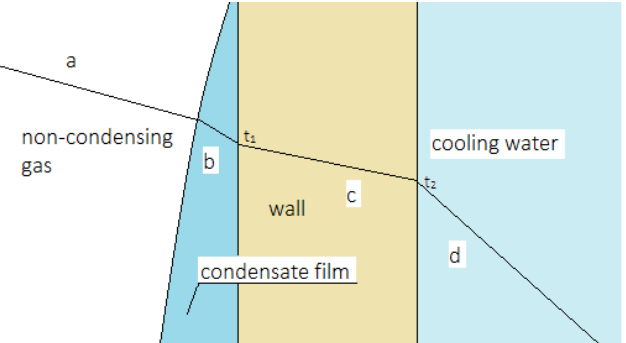
Fig. 2. Heat transfer in FGC. a – heat transfer of sensible heat of non-condensable gases; b – thermal conduction through condensate film; c – thermal conduction through wall; d – convective heat transfer from wall to cooling water. Colburn and Hougen noted that during the condensation of vapours from their admixture of non-condensable gases, the properties of the gas stream vary greatly as the vapour is removed [28]. As for FGC, the wall temperature is lower than the dew point temperature, which